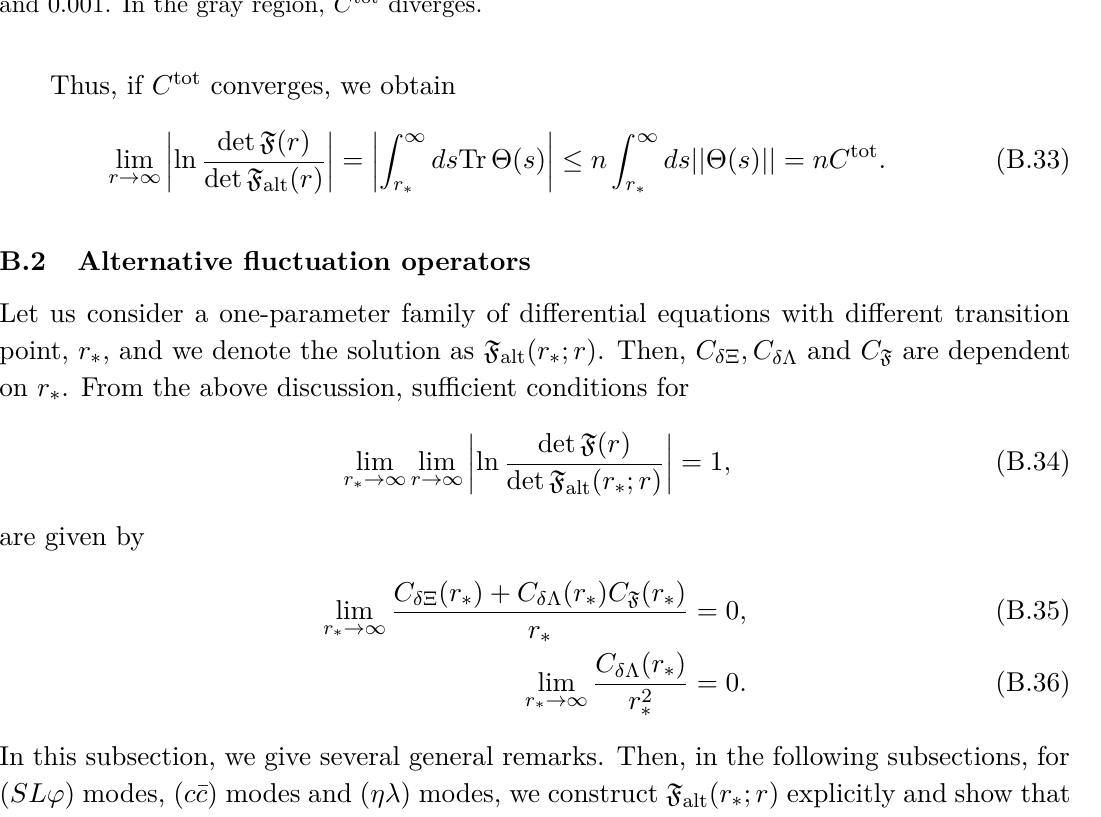
Figure 1 . Contours of constant C tot , taking k = 2 . 5 . The dashed lines indicate C tot = 0 . 1 , 0 . 01 , and 0 . 001 . In the gray region, C tot